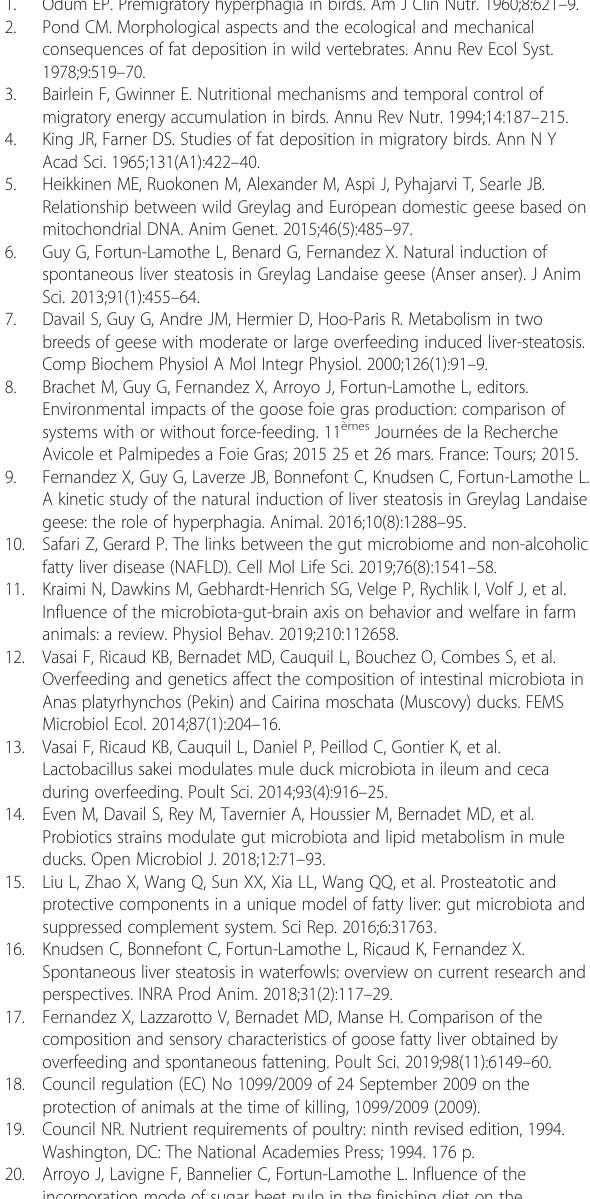
Supplemental Figure 2 . Selection of PosSF and NegSF birds after the Ad libitum feeding period (245 days of age) in the alternative system. A) Body composition and B) biochemical composition of the livers in the different groups. Additional file 2: Supplemental Table 1. Pairwise Adonis tests between groups. Supplemental Table 2 Relative abundance (%) of the top 10 OTUs contributing to PLS-DA axis 1 on PosSF and NegSF groups. Supplemental Table 3 . Relative taxonomic abundance (in %) in ileal content at phyla level according to the experimental group. Supplemen- tal Table 4 . Relative taxonomic abundance (in %) in ileal content at fam- ily level according to the experimental group. Supplemental Table 5 . Relative taxonomic abundance (in %) in ileal content at genus level